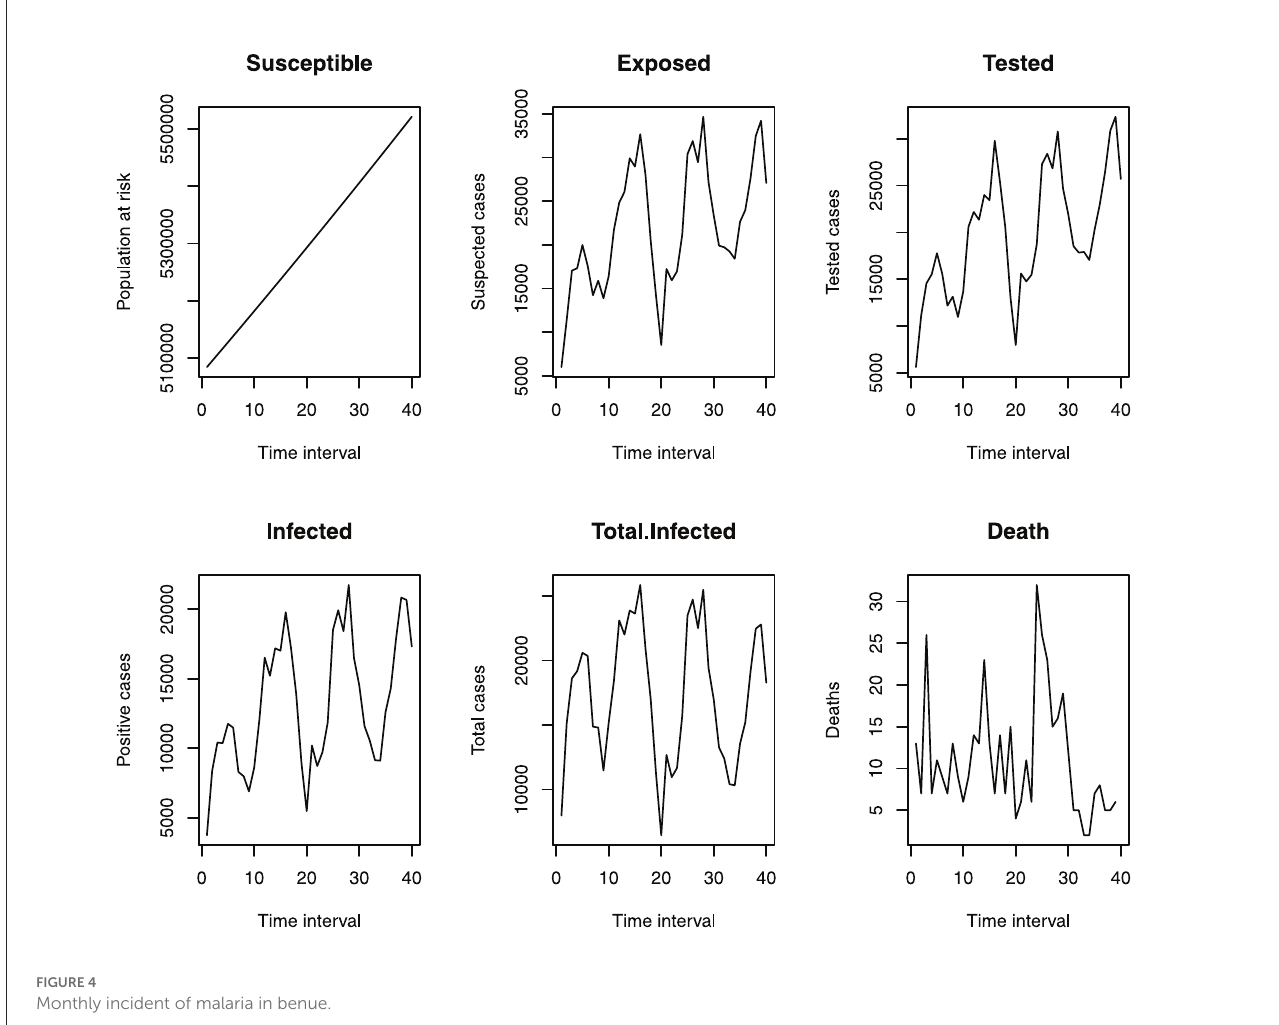
FIGURE4 Monthly incident of malaria in benue.